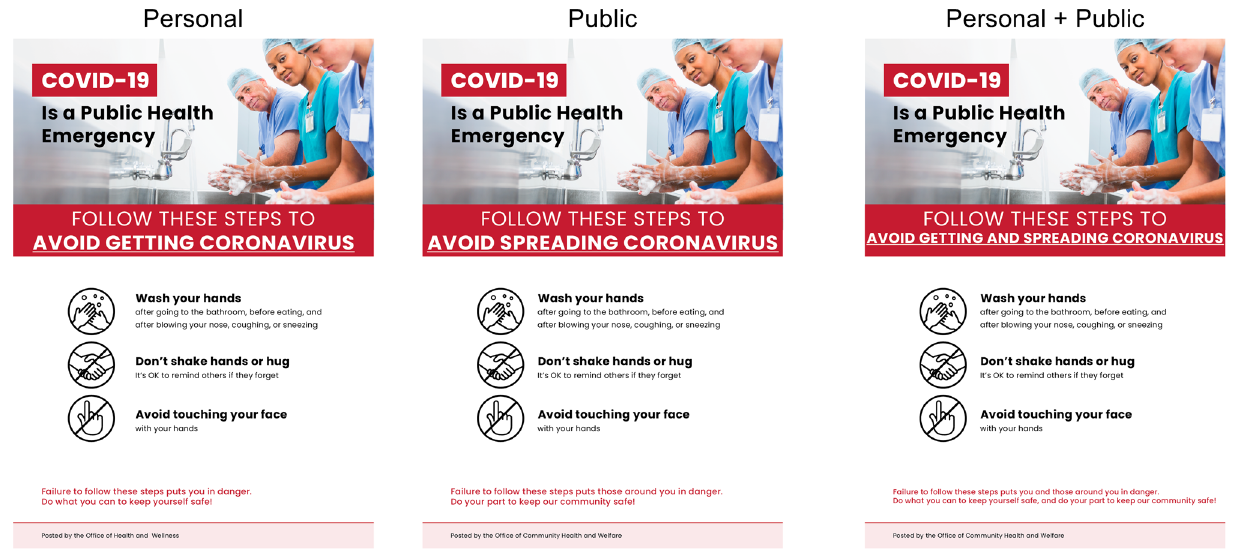
Figure 1. Fliers shown in each treatment. Photograph attribution: